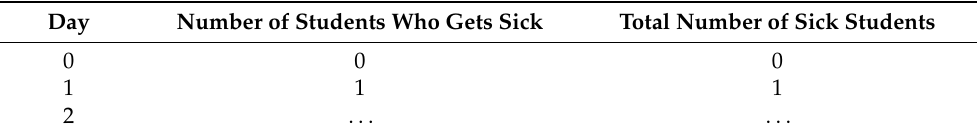
Table 8. Each student infects two colleagues.